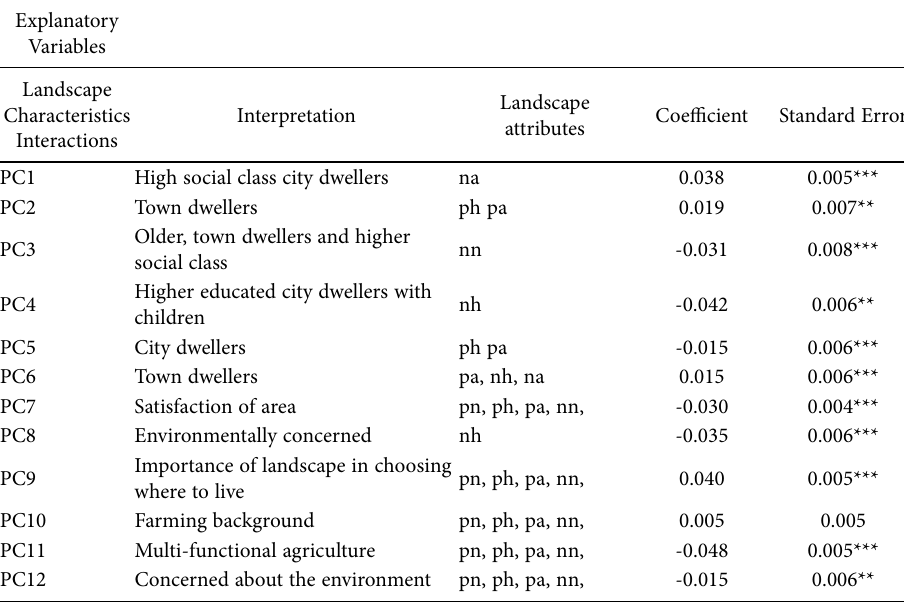
Table 7. Coefficients of Pooled OLS Model interacted with Taste Shifter Principal Components. Explanatory Variables Landscape